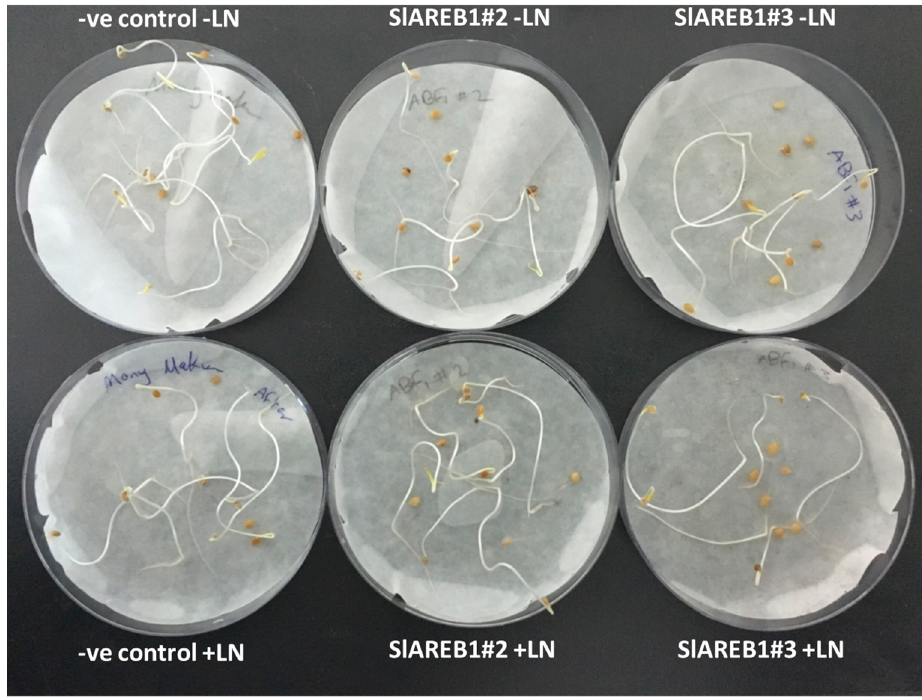
Figure 9. Seed germination of two transgenic lines overexpressing SlAREB1 (SlAREB1#2 and SlAREB1#3) and negative control (-ve control) after 10 days of desiccation with silica gel and treatment with liquid nitrogen (+LN) or without liquid nitrogen ( − LN).